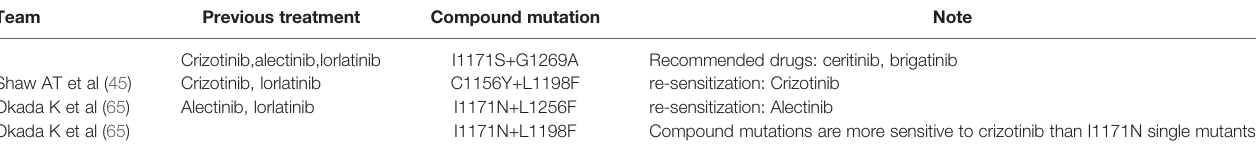
TABLE 3 | Compound mutations and Treatment